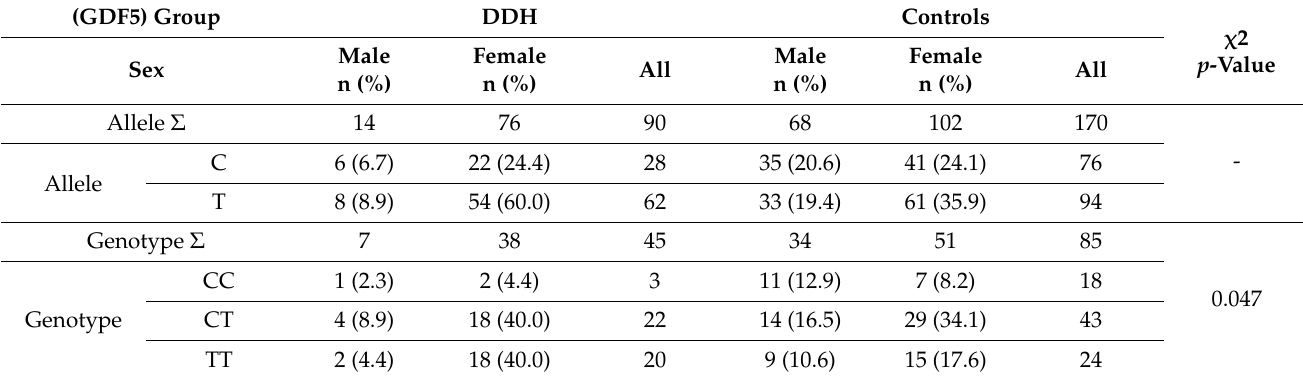
Table 3. Distribution of alleles and genotypes in association to rs143383 in the GDF5 gene and DDH occurrence. (GDF5) Group